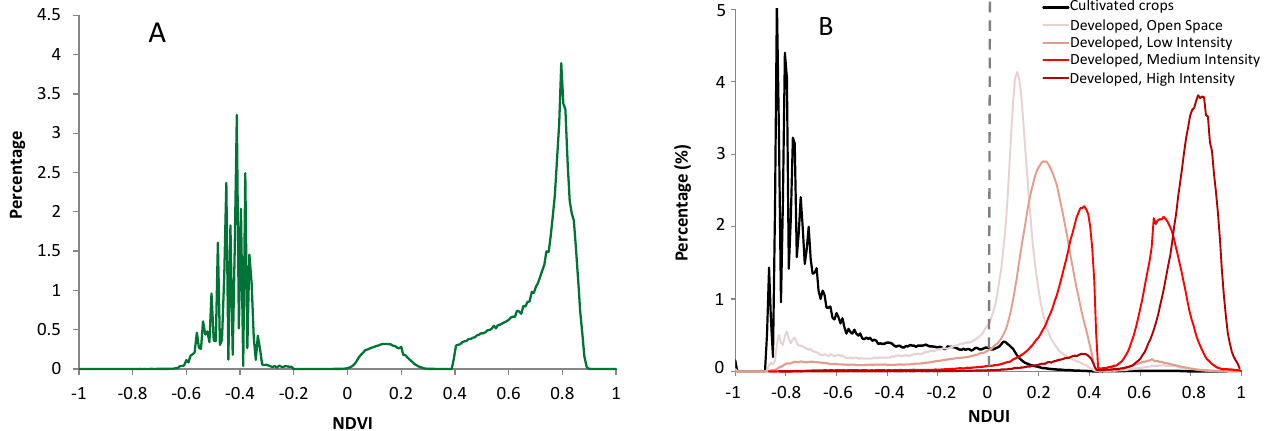
Figure 11. The distribution of NDVI values in the 2006 NDVI composite ( A ) and the distribution of the 2006 NDUI within each NLCD 2006 Developed class and the Cultivated Crops class, excluding water, in the Chicago region ( B